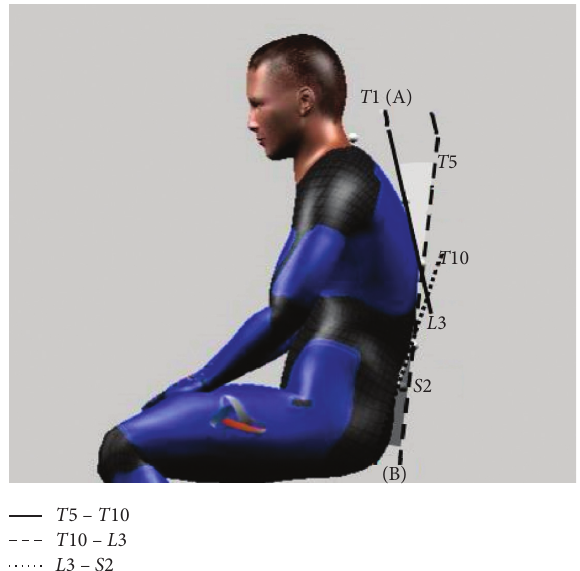
Figure 2: Measurement of thoracolumbar kyphosis and lumbar lordosis through 3D motion analysis system. (A) Thoracolumbar kyphosis angle and (B) lumbar lordosis